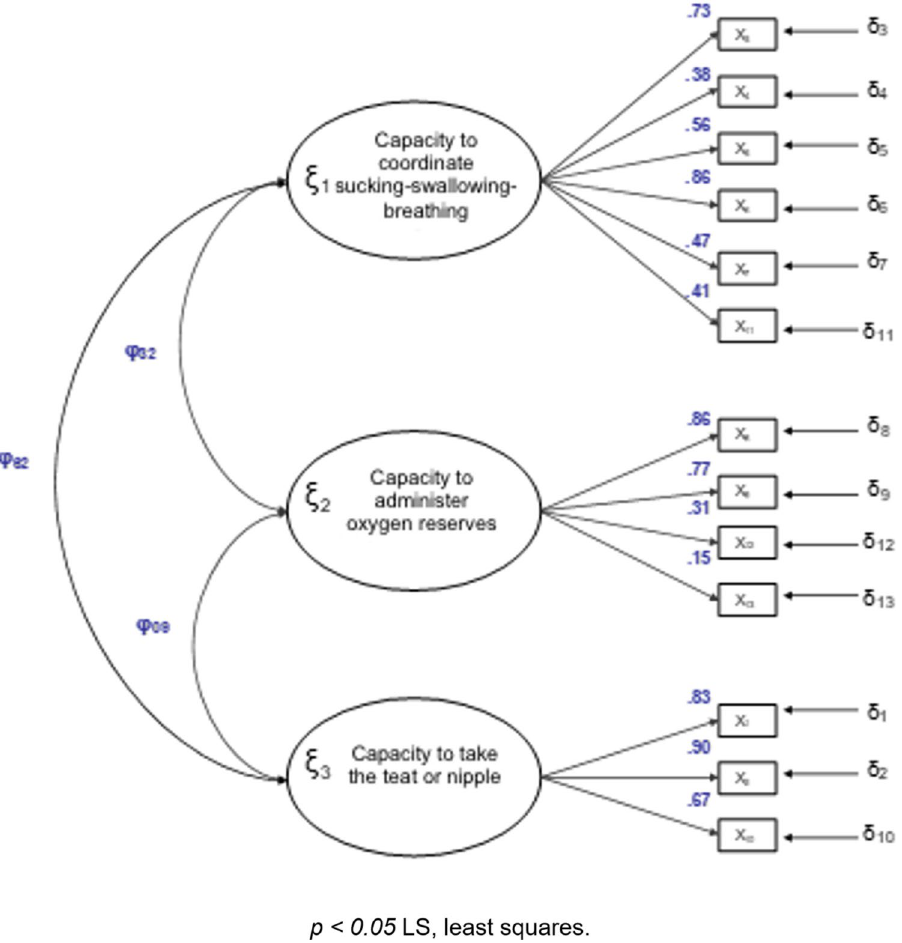
Figure 2. Model specification with 3 factors and 13